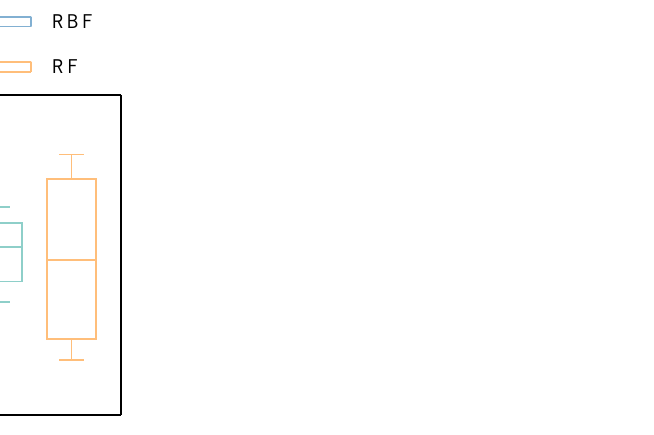
Figure 11. Box plot of test relative error results based on different machine learning algorithms. Table 3. The prediction results under test